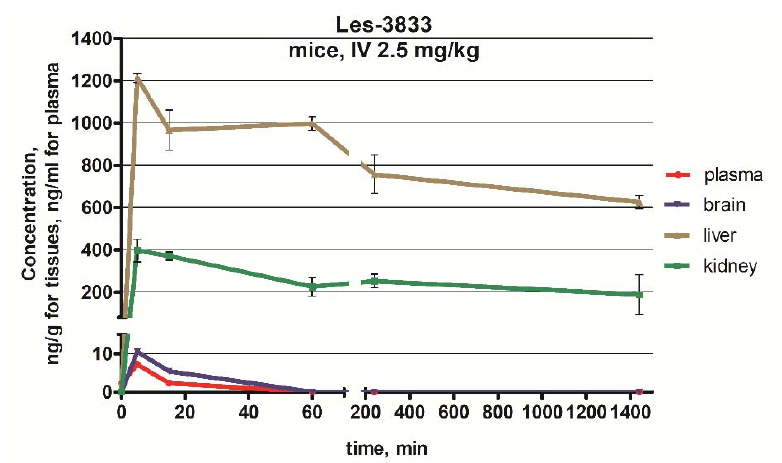
Figure 3. Concentration–time curves for Les-3833 following dosing during 24 h in the plasma, brain, liver, and kidney of male Balb / c mice. Since the concentrations of Les-3833 were very low for plasma (approximately 5 ng / mL) and brain ( < 10 ng / g), the X -axis and Y -axis each consist of two segments. Mean values of C max after IV dosing reached approximately 1190 and 404 ng / g in liver and kidney, respectively (Table 3). Overall bioavailability in the brain was slightly poorer, with a mean C max of 7.17 ng/g after IV exposure.